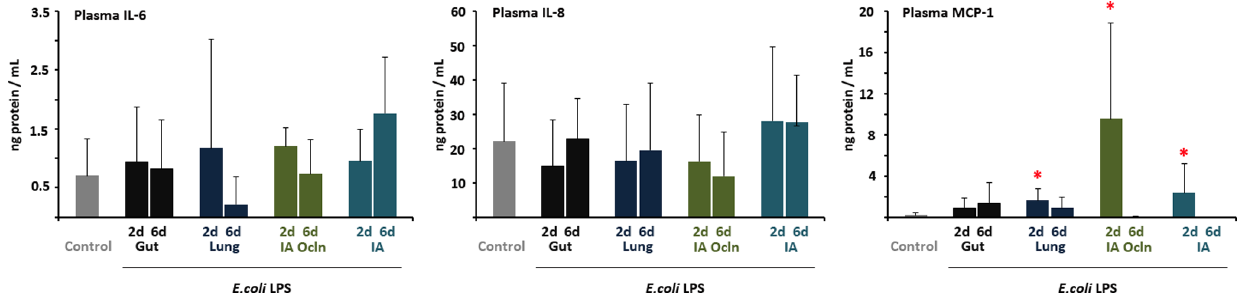
Figure 3. LPS infusion in the lung or the amniotic fluid increased MCP-1 levels in the plasma. IL-6, IL-8 and MCP-1 protein levels in the plasma were measured by ELISA, (A) IL-6 and (B) IL-8 and (C) MCP-1. MCP-1 but not IL-6 or IL-8 levels increased in the plasma in the 2d ‘‘Lung’’, 2d ‘‘IA Ocln’’ and the 2d ‘‘IA’’ LPS groups (* p , 0.0125 vs. control for MCP-1, p , 0.05 vs. control for IL-6 and IL-8). doi:10.1371/journal.pone.0063355.g003 PLOS ONE |